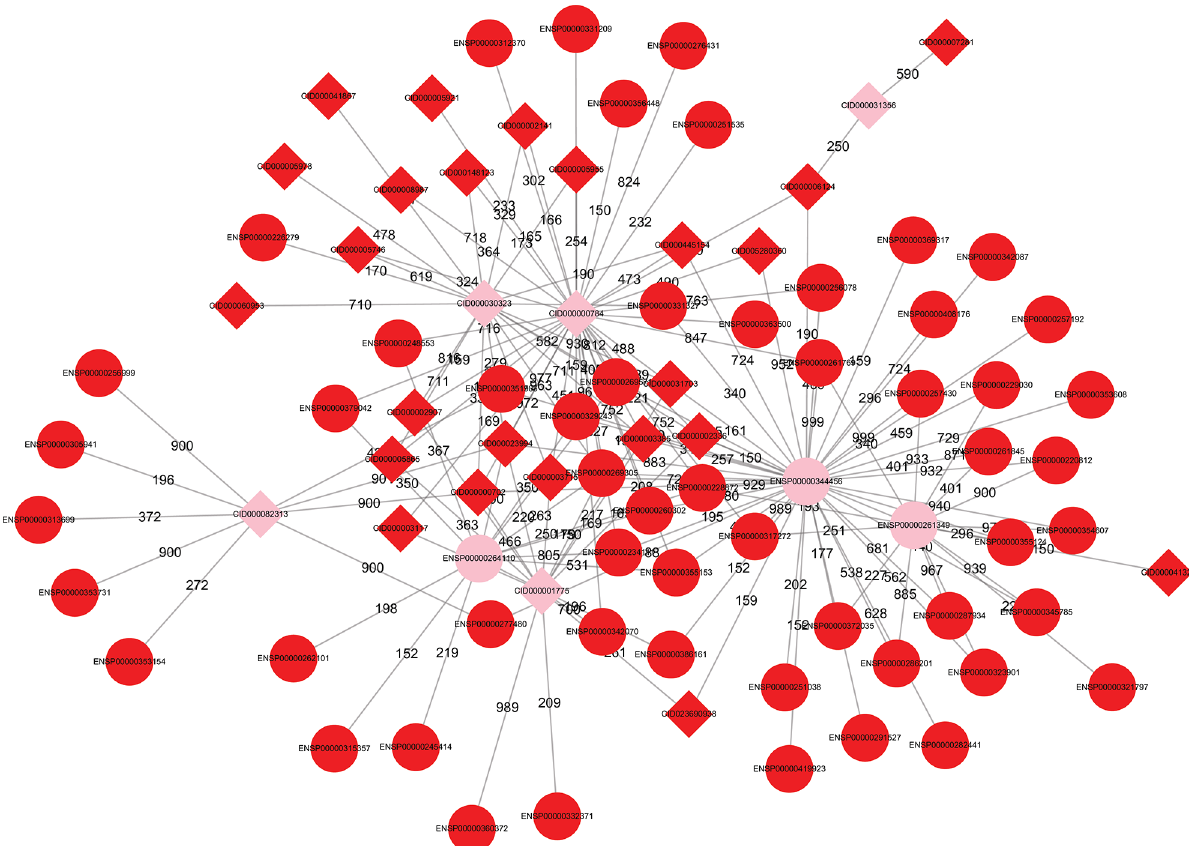
Fig 1. The network of highly possible novel esophageal cancer related genes and chemicals and known genes and chemicals related to esophageal cancer. The pink nodes were highly possible novel esophageal cancer-related genes and chemicals. The red nodes were known genes and chemicals related to esophageal cancer. The round nodes were genes and the diamond nodes were chemicals. The edge labels were the confidence scores of the